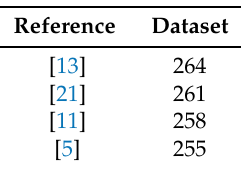
Table 1. Different numbers of reported ground truth eye blinks in the ZJU dataset.